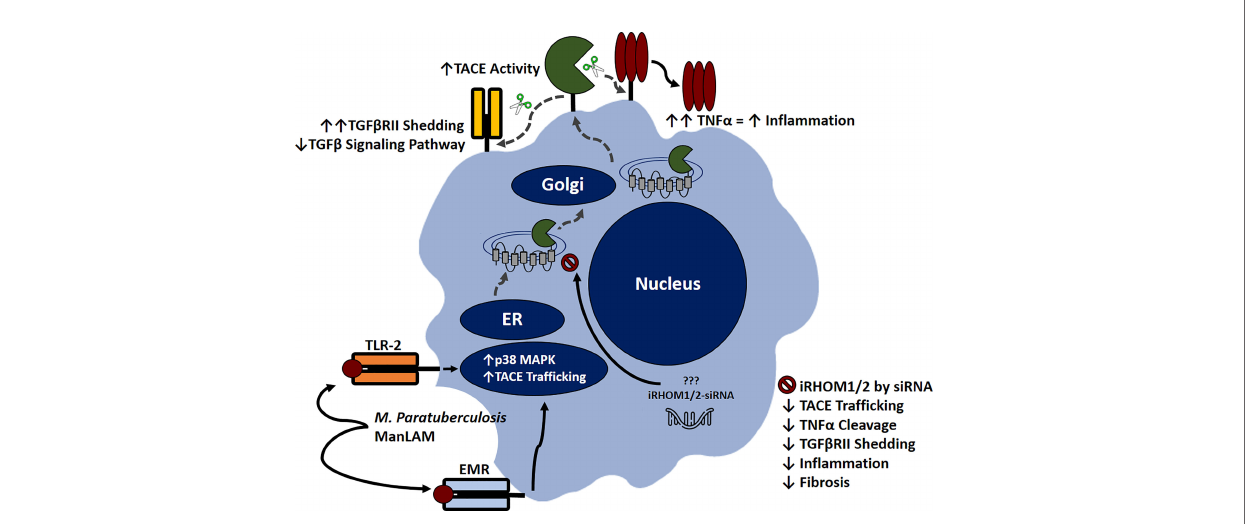
FIGURE 11 | Inhibitory rhomboid proteins (iRHOM1/2) regulate TNF- a converting enzyme (TACE) membrane traf fi cking. Macrophages recognize M. paratuberculosis ManLAM through toll-like 2 receptors (TLR-2) and external mannose receptors (EMR). Upon binding, the p38 MAPK pathway is activated, which facilitates TACE traf fi cking from the ER to the cell surface via iRHOM1/2 regulation. Increasing TACE activity cleaves transmembranous TNF- a and induces TGF b RII shedding, which exacerbates in fl ammation and attenuates TGF- b signaling pathway. Silencing iRHOM1/2 downregulates TACE traf fi cking and maturation, which consequently decreases TNF- a cleavage and restores TGF- b signaling